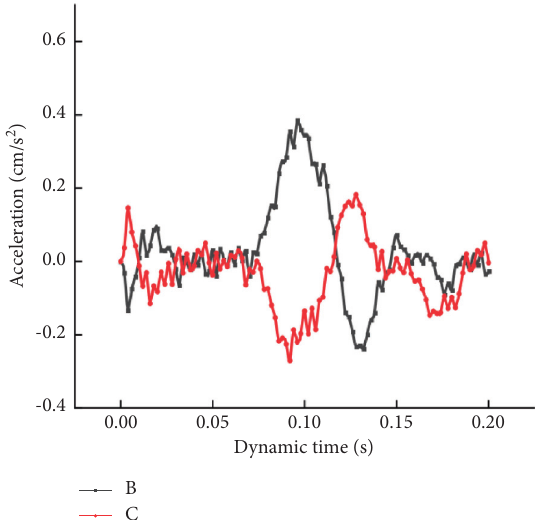
Figure 8: Acceleration time-history curve of the tunnel arch waist.